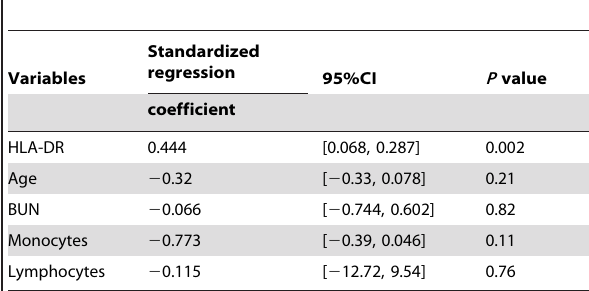
Table 2. Correlations between TRAIL and other clinical variables.